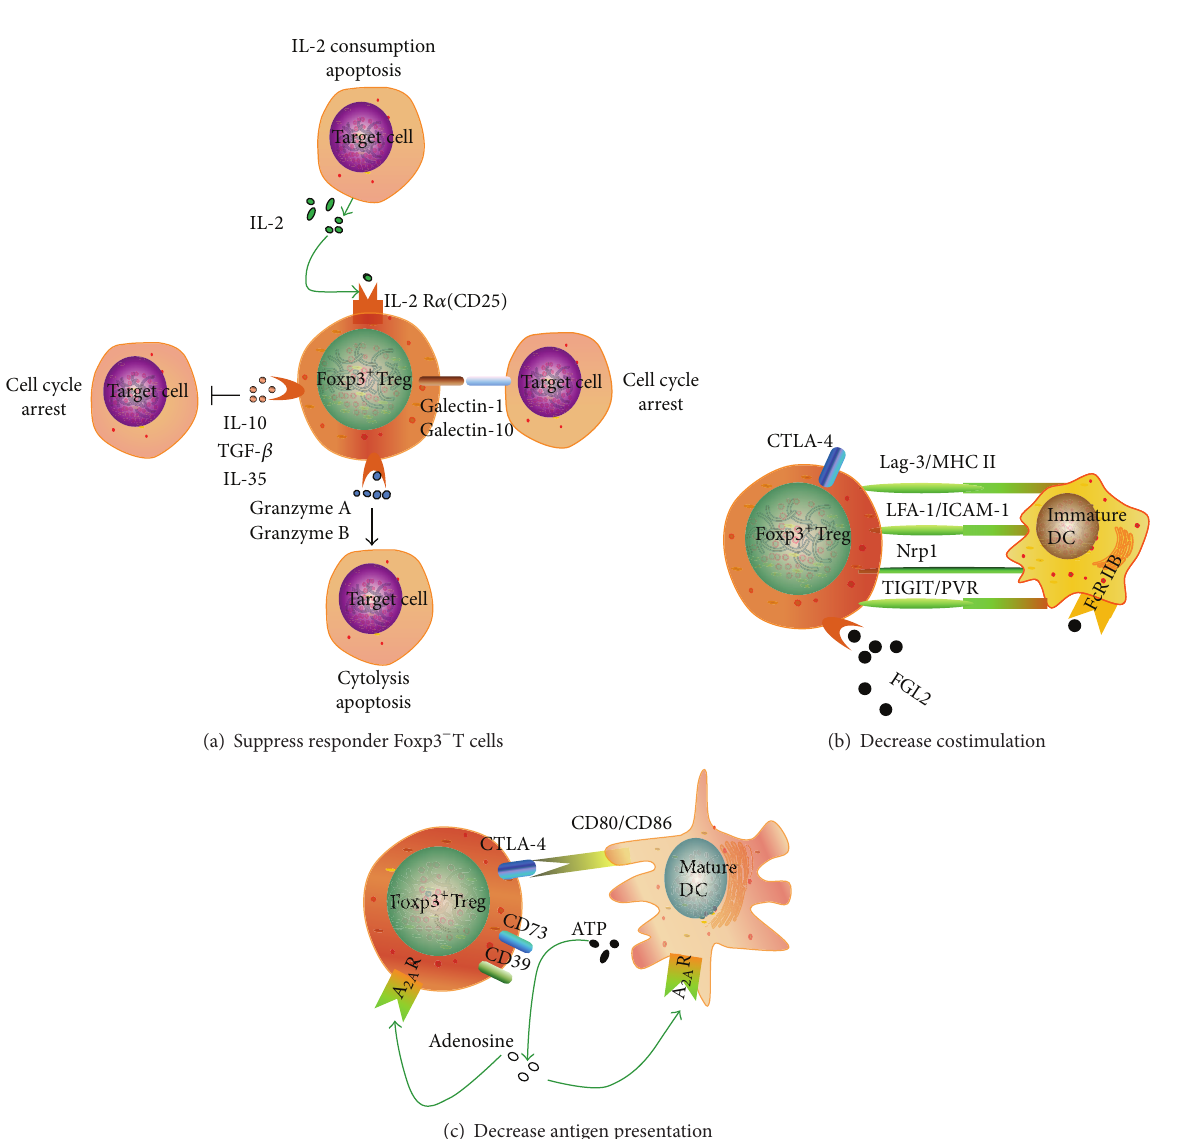
Figure 1: The mechanisms by which Tregs suppress the immune response. The main mechanisms include those that target Foxp3 − T cells (cell cycle arrest, IL-2 consumption, apoptosis, and cytolysis) and those that primarily target dendritic cells (decreased costimulation or decreased antigen